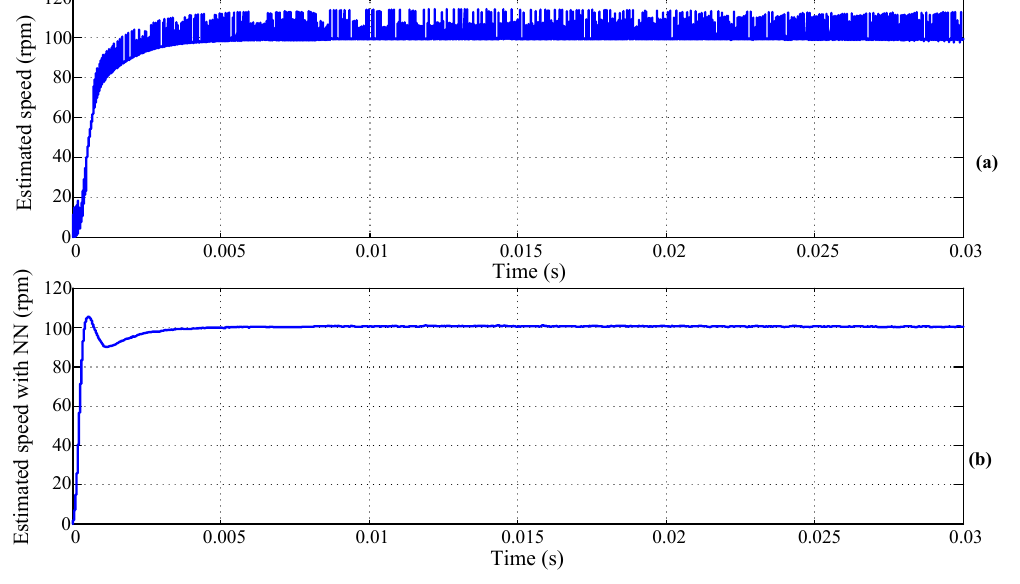
Figure 6. The step speed responses of 100 rpm by (a) ISMO and (b) NN-ISMO.